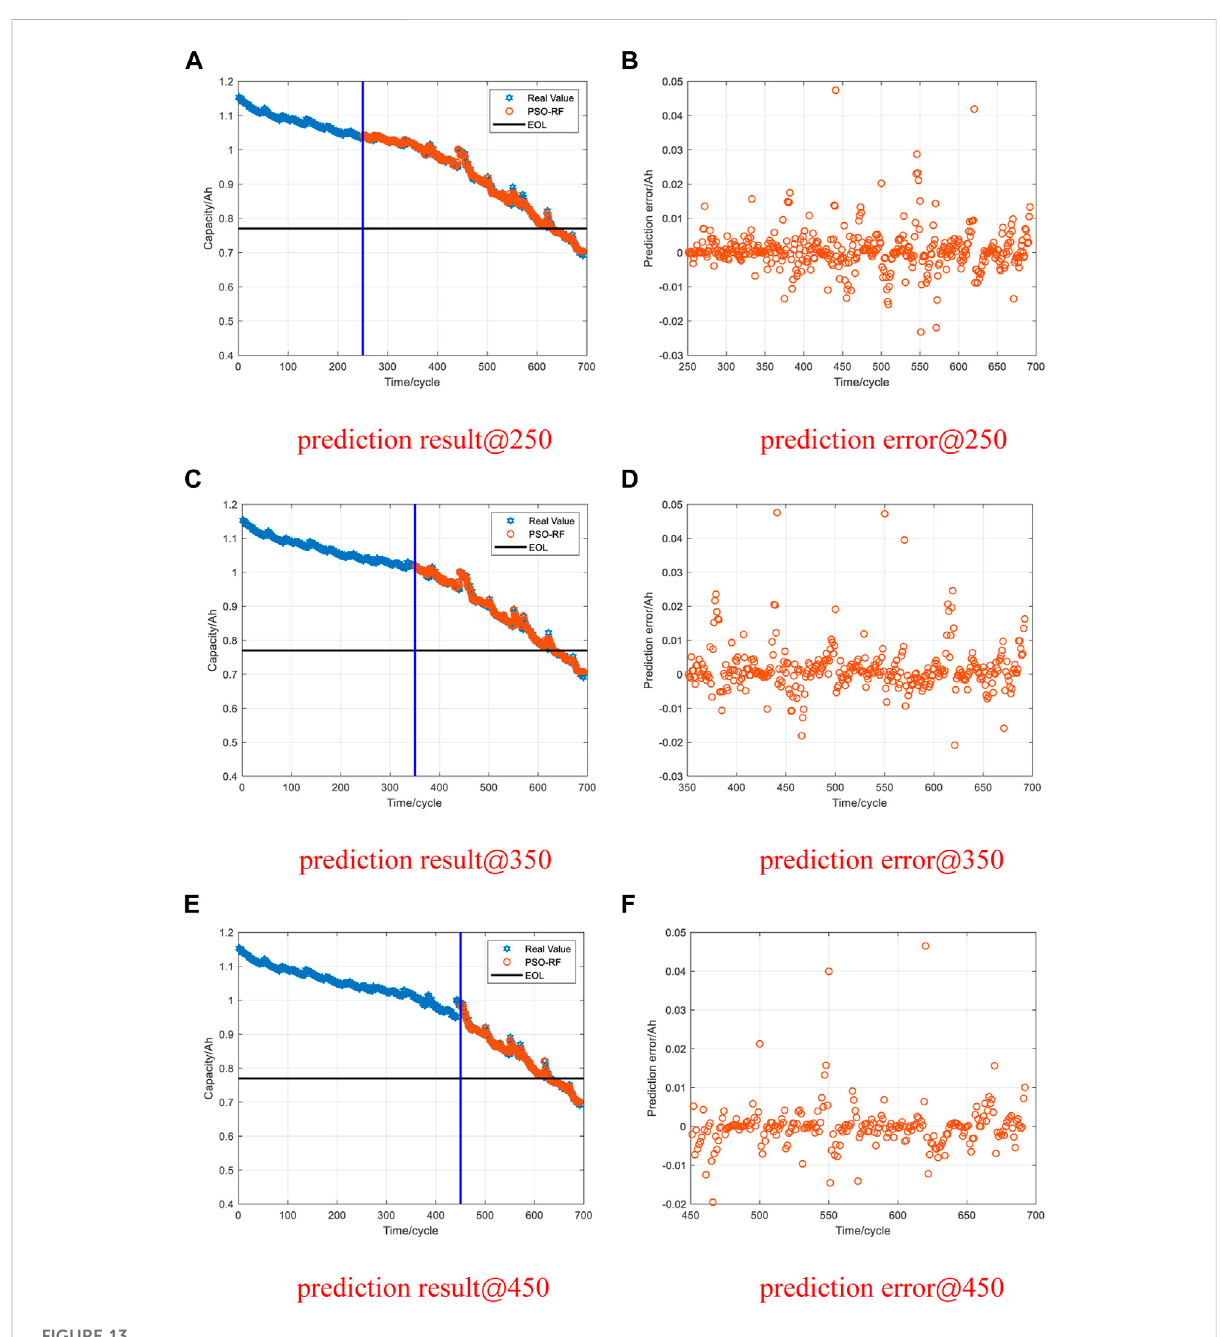
FIGURE 13 Results and errors of CS2-34